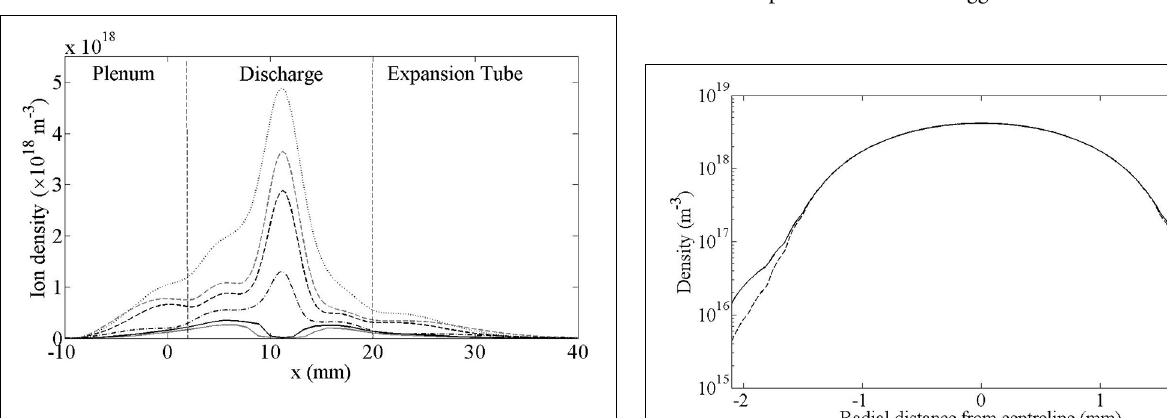
FIGURE 9 | Ion density along the central axis with changing secondary electron coefficient on the alumina tube and grounded metal walls. Coefficients are 0.001 (solid gray line), 0.01 (solid black line), 0.02 (dot dashed black line), 0.05 (dashed black line), 0.1 (dashed gray line) and 0.2 (dotted black line).